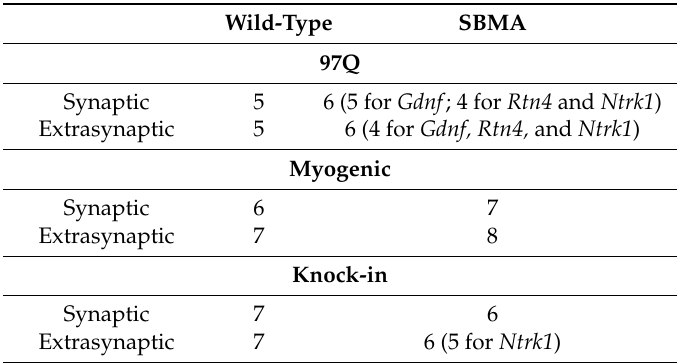
Table 2. Sample sizes (n) by model and muscle region, n = number of